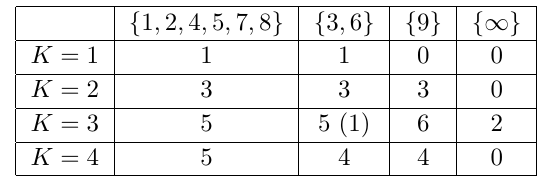
Table 6 . Number of Bethe roots for decomposed BAE with M = 9.